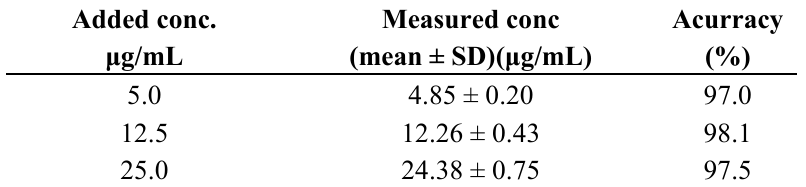
Table 2. The accuracy result of armodafinil by the established method (n = 9). Added conc.